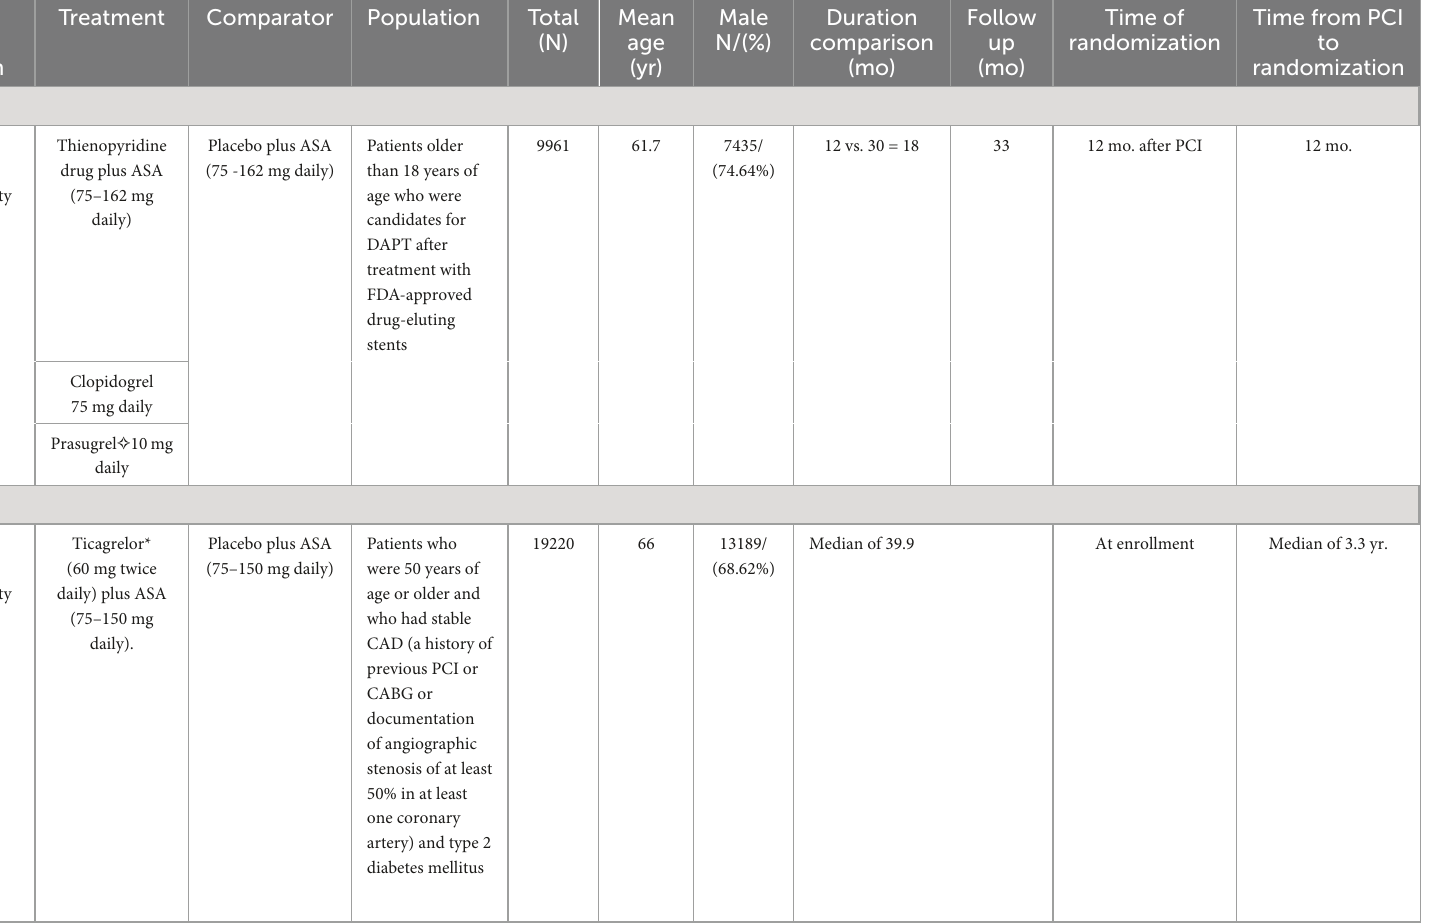
TABLE 1 Characteristics of the included studies and